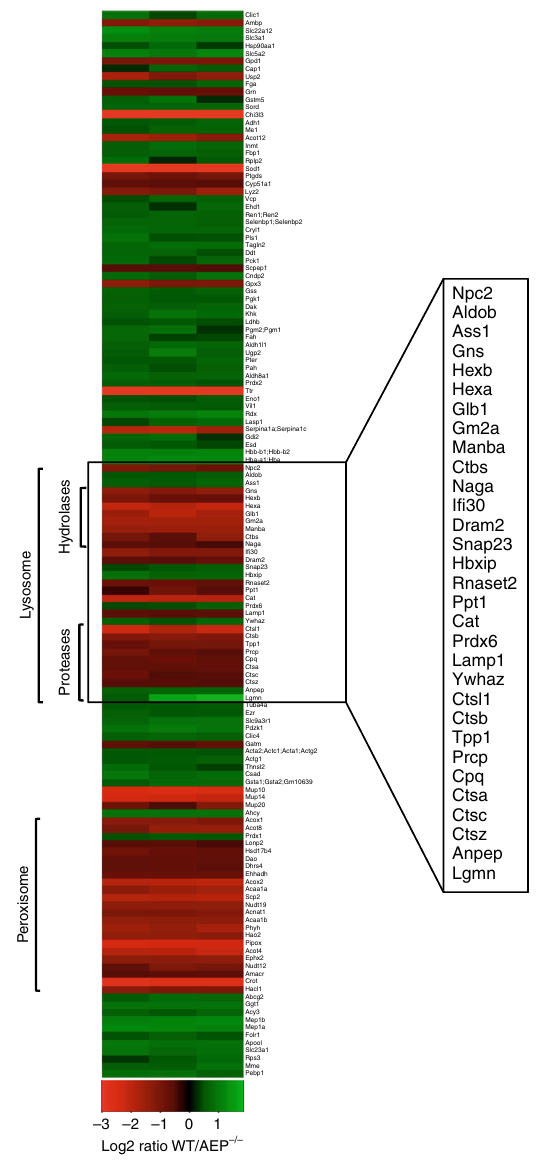
Fig. 2 Lack of AEP induces an increase in the hydrolytic capacity of lysosomes in vivo. Heatmap built using heatmap.2 in the gplots package of R program showing proteins over-represented (red) or under-represented (green) in the AEP − / − lysosomal kidney fractions compared to WT samples as identi fi ed by our SILAC approach, organised by cellular location and molecular